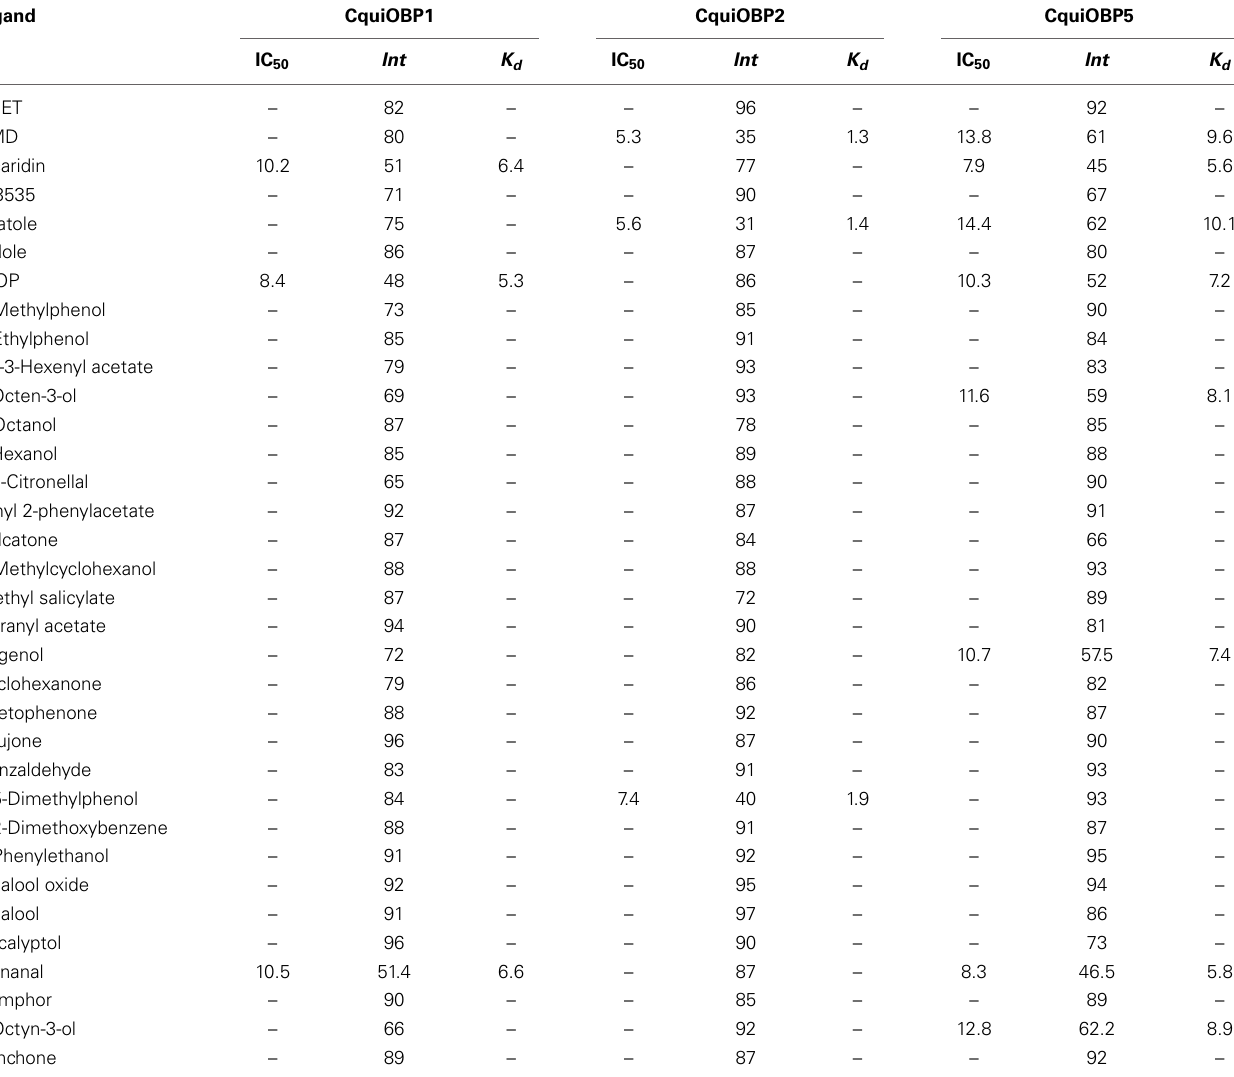
Table 1 | Binding affinities of CquiOBPs to a group of compounds.